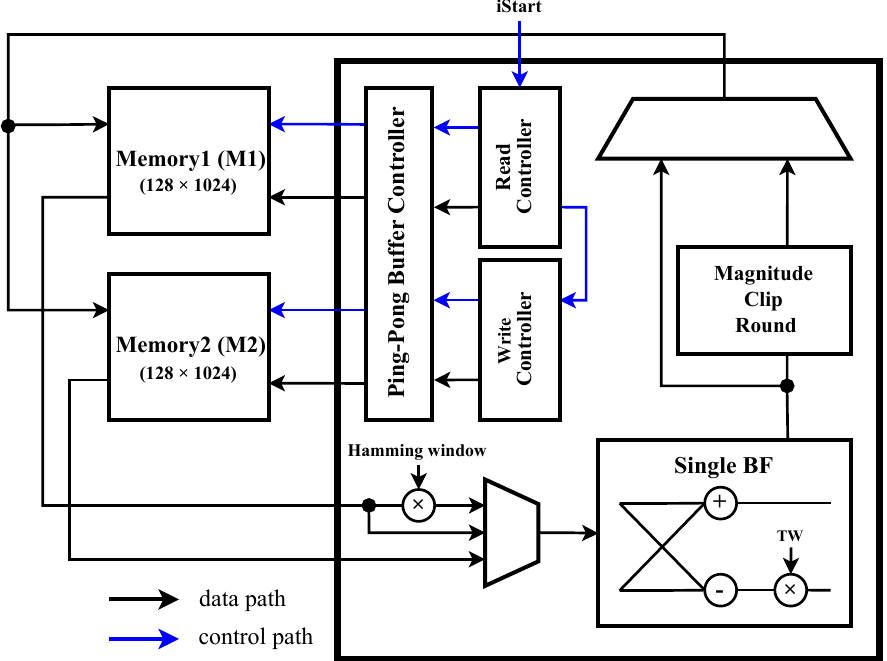
Figure 8. Block diagram of the STFT